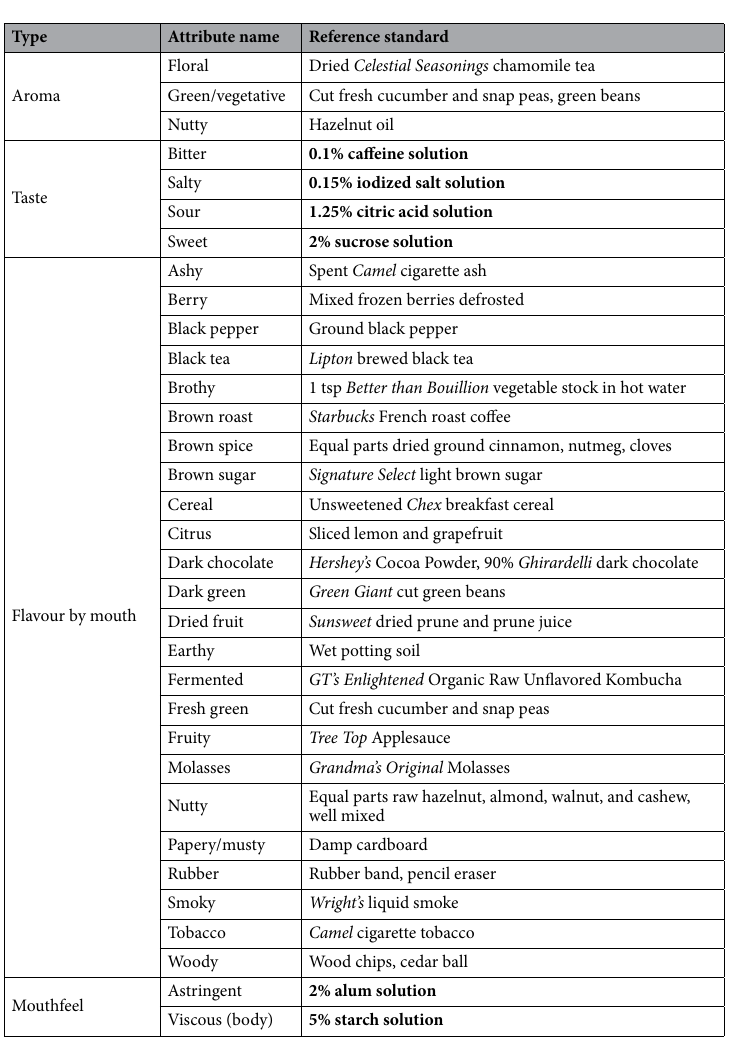
Table 1. Sensory attributes and corresponding references for panellist training. Bolded references were aqueous solutions (mass percent) consumed by mouth; all others were aroma references.